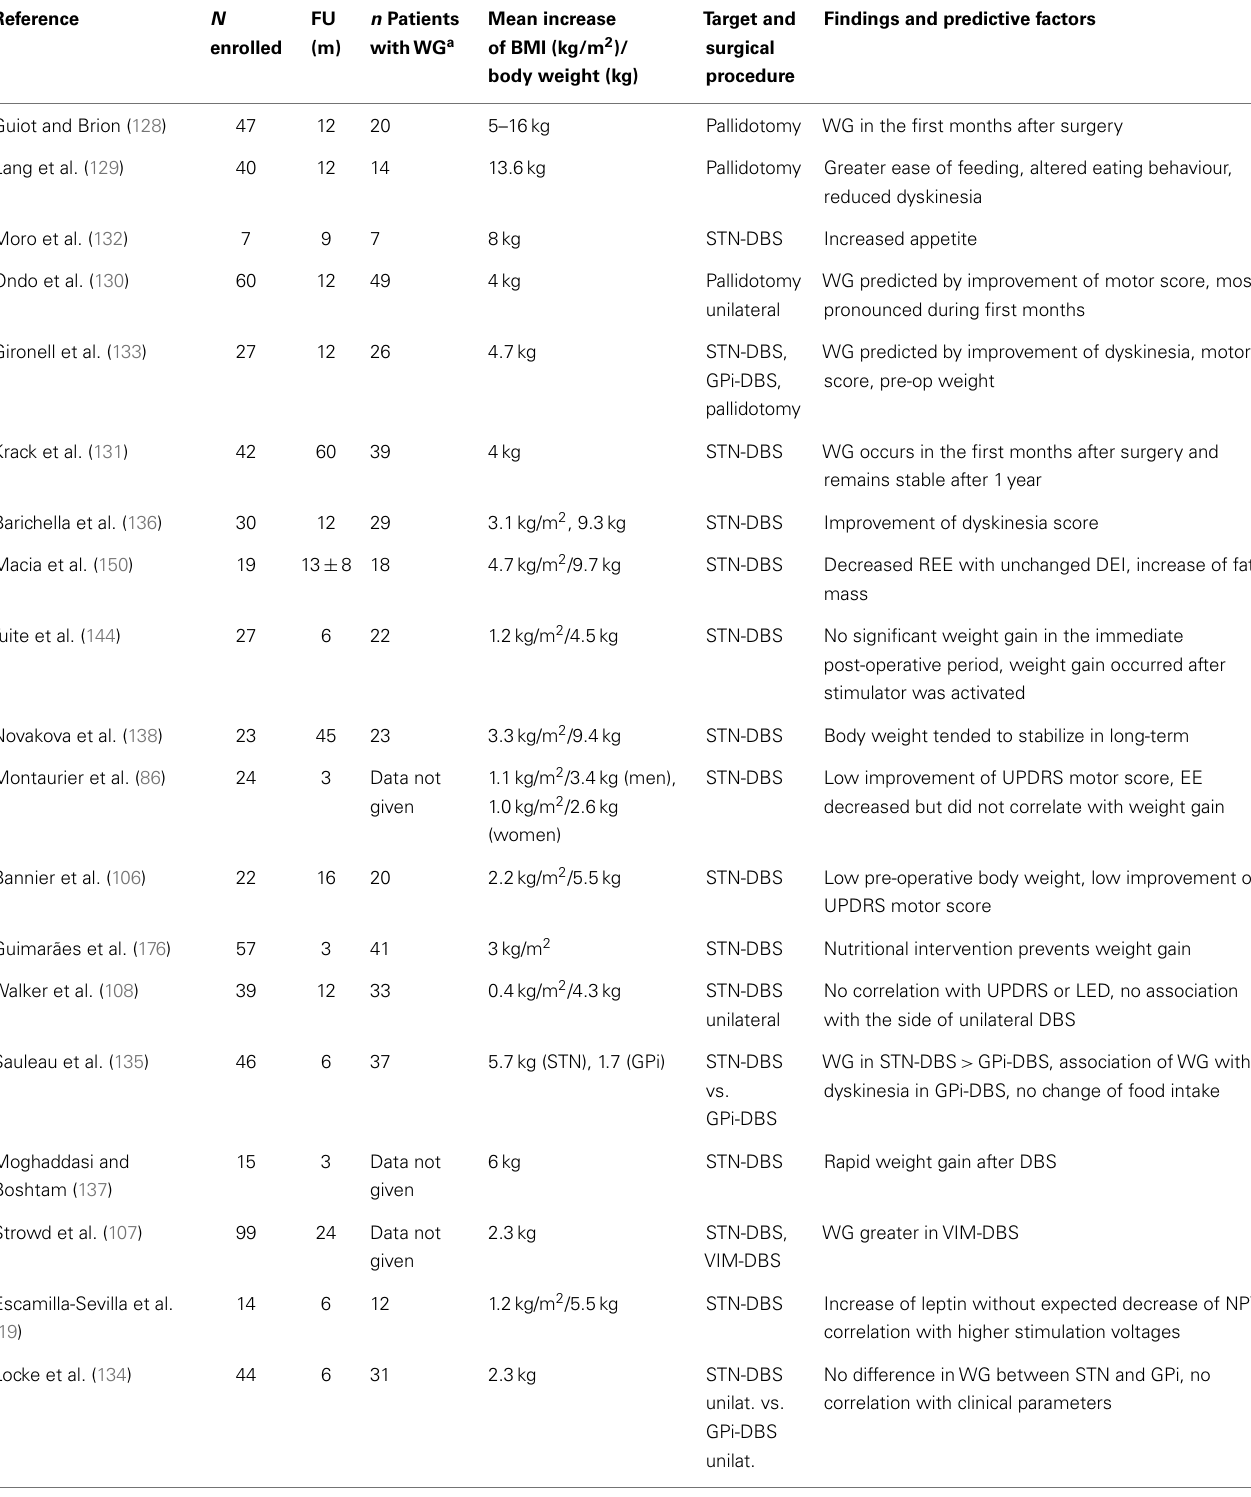
Table 2 |Weight gain in PD after surgical treatment: possible mechanisms and predictive factors